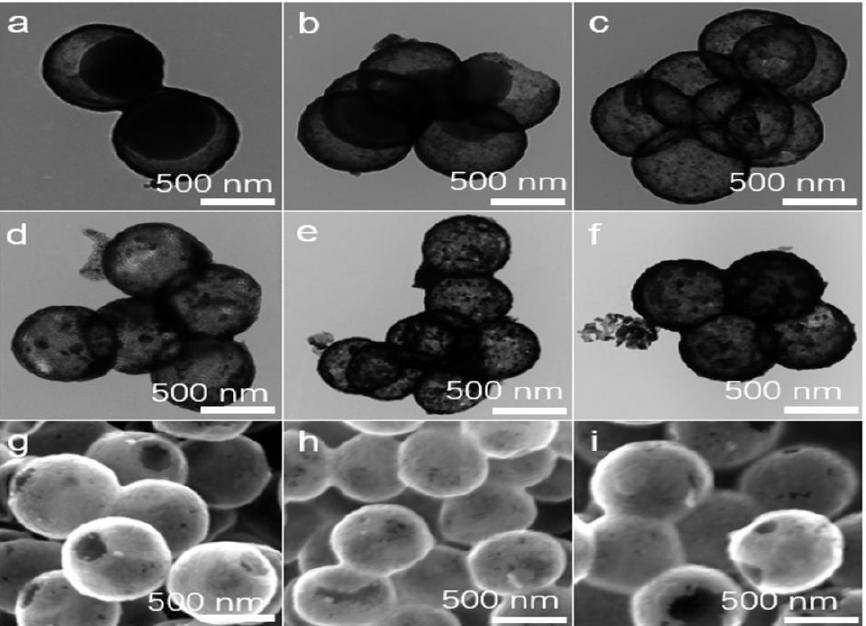
Figure 2. ( a – c ) TEM images of the obtained APF − TiO 2 − 1, APF − TiO 2 − 2 and APF − TiO 2 − 3 photocata- lysts under air calcining. ( d – f ) TEM images of the obtained C − TiO 2 − 1, C − TiO 2 − 2 and C − TiO 2 − 3 under N 2 carbonization for 2 h and ( g – i ) the corresponding SEM images. The scale bar is 500